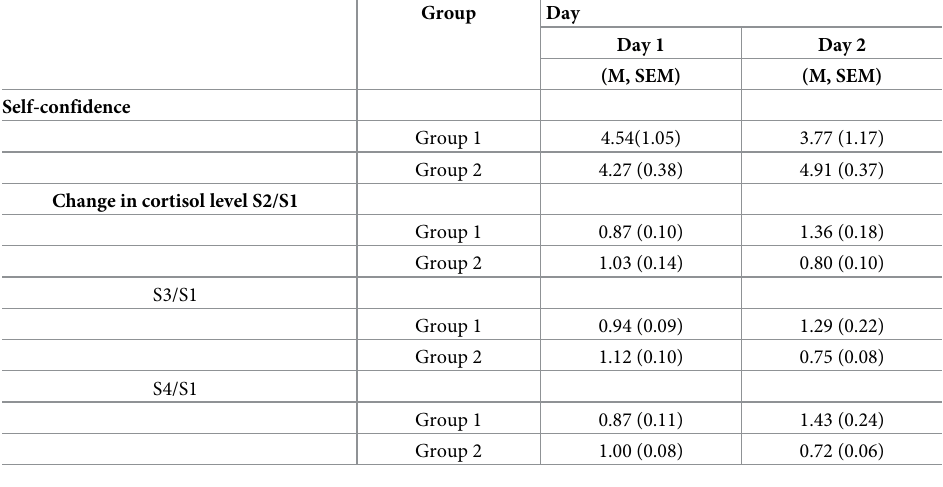
Table 2. Means and standard errors of the mean of the confidence rating scale after the phone call and changes in cortisol levels in Hugvie users and only-mobile-phone users in Group 1 and Group